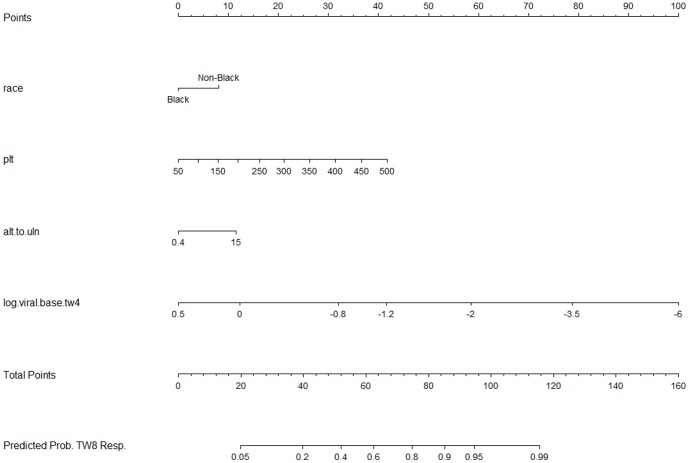
Nomogram for predicting TW8 response in null responders, partial responders, relapsers and previously untreated patients treated with Boceprevir + PR.Instructions: This nomogram is a visual representation of the regression model built to predict TW8 response to boceprevir. It can be used to calculate a patient's predicted probability of becoming undetectable at TW8 if they have initiated boceprevir treatment. To use it, first circle the patients TW4 HCV-RNA on the TW4 HCV-RNA scale. By drawing a straight line upwards to the points scale. This represents the number of points for that patient based upon their TW4 HCV-RNA level. For example, if they have a value of ≤1500, the point score would be 100. Repeat this procedure for each of the variables presented in the nomogram. Once all point scores are determined, sum the total points and circle that value on the Total Points scale after the last variable. Draw a straight line downward from the Total Points scale to determine an individuals predicted probability of a TW8 response.